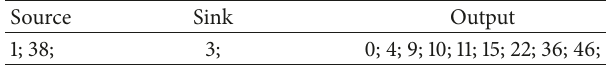
Table 1: Defining the connections of the network.